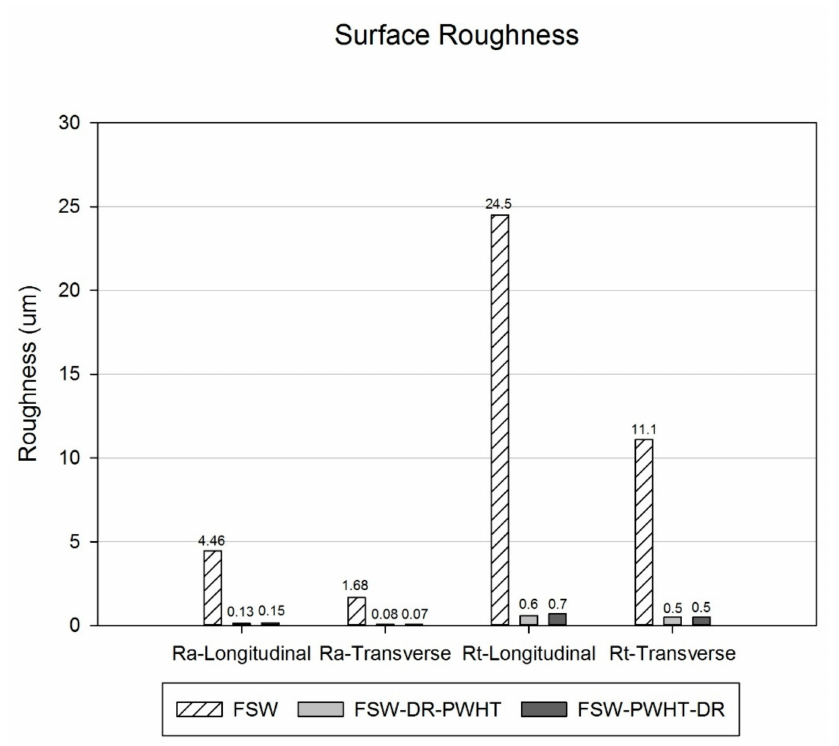
Figure 14. Surface roughness test